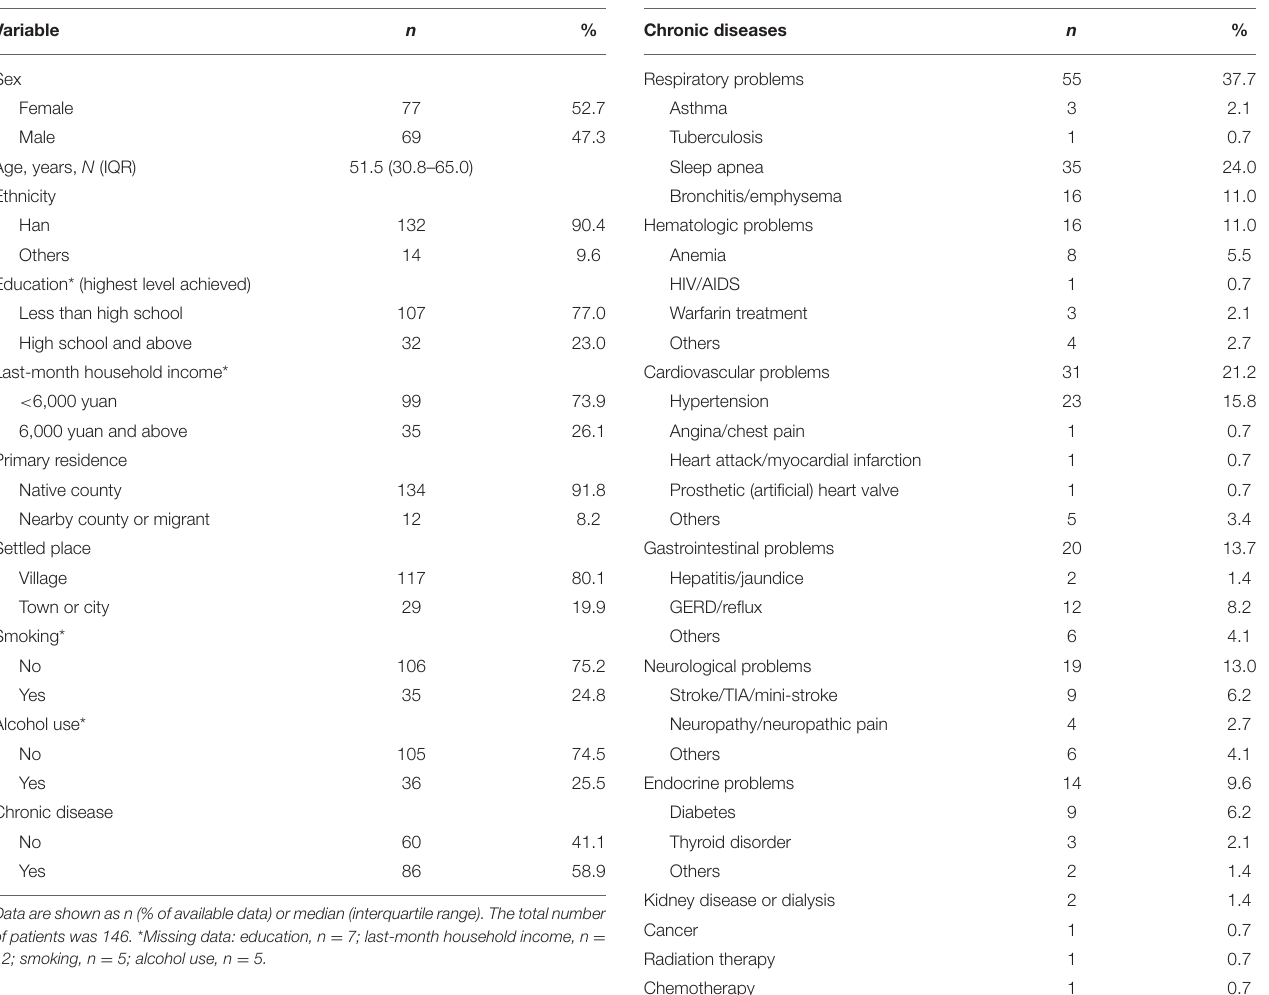
TABLE 1 | Characteristics of patients. TABLE 2 | Distributions of chronic